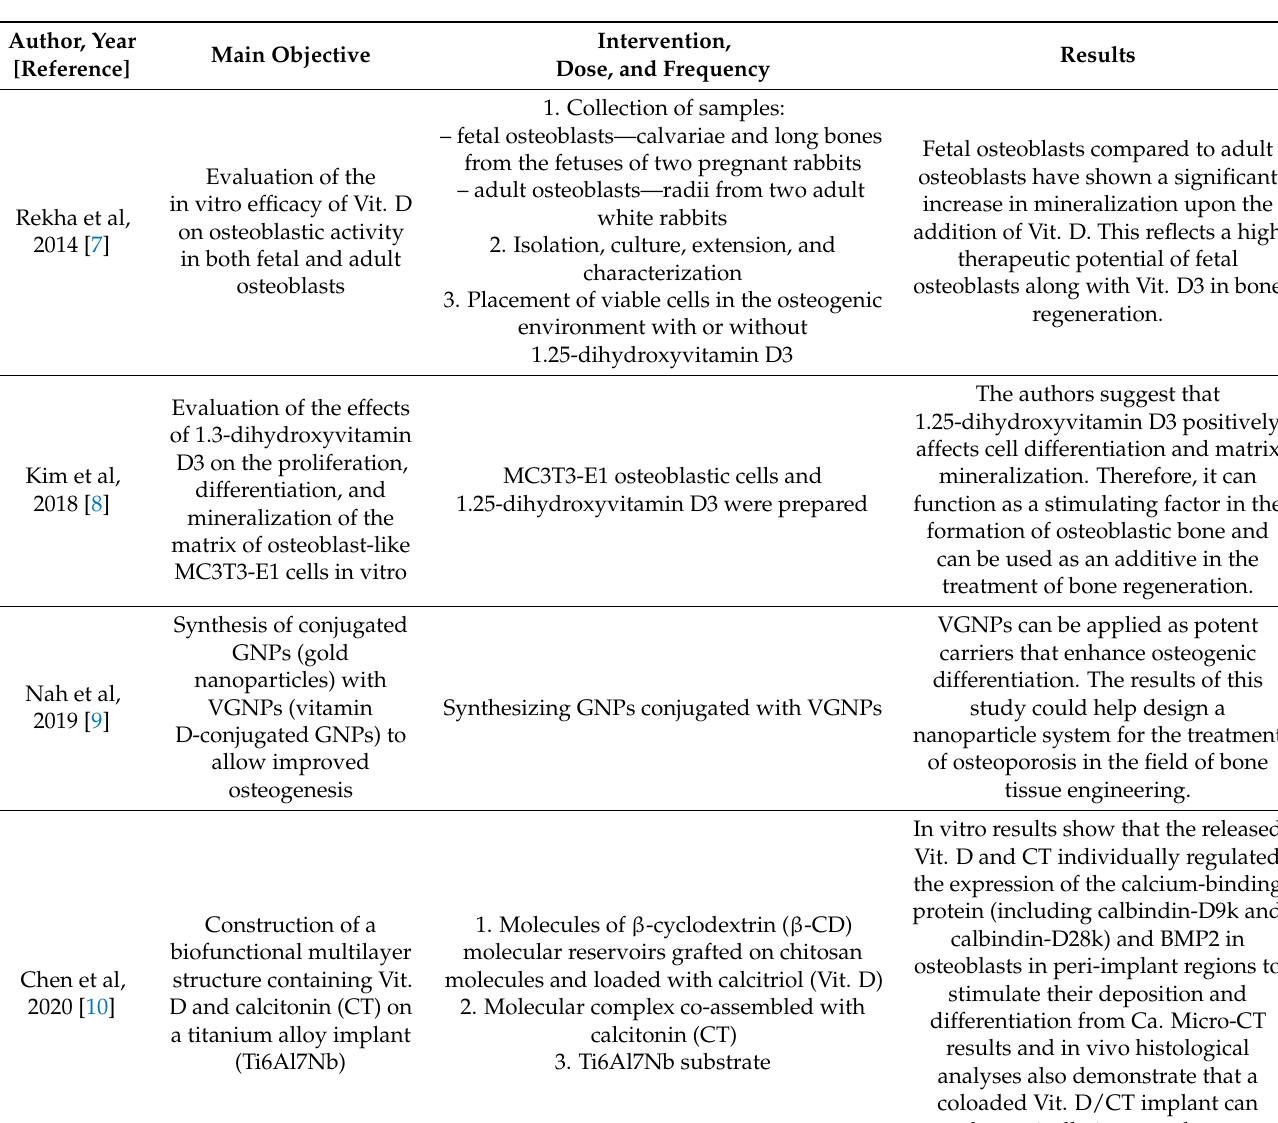
Table 2. Characteristics of the in vitro studies and their